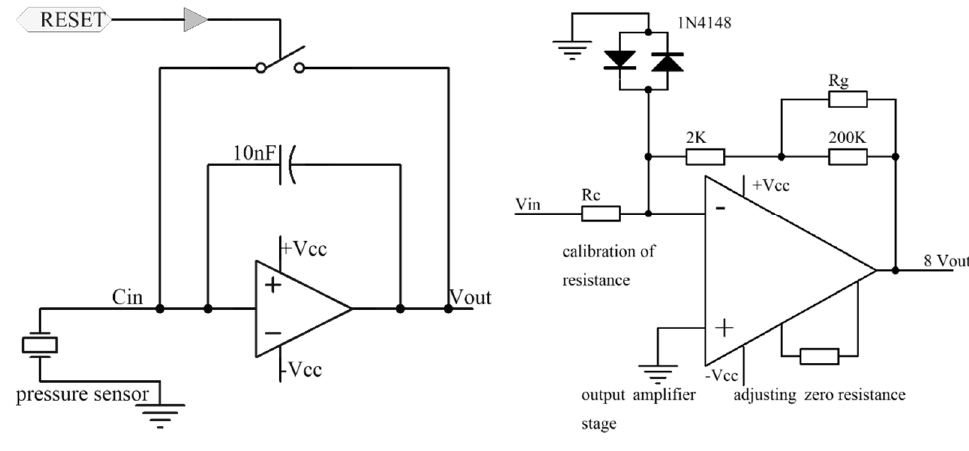
Figure 4. Charge amplifier circuit.